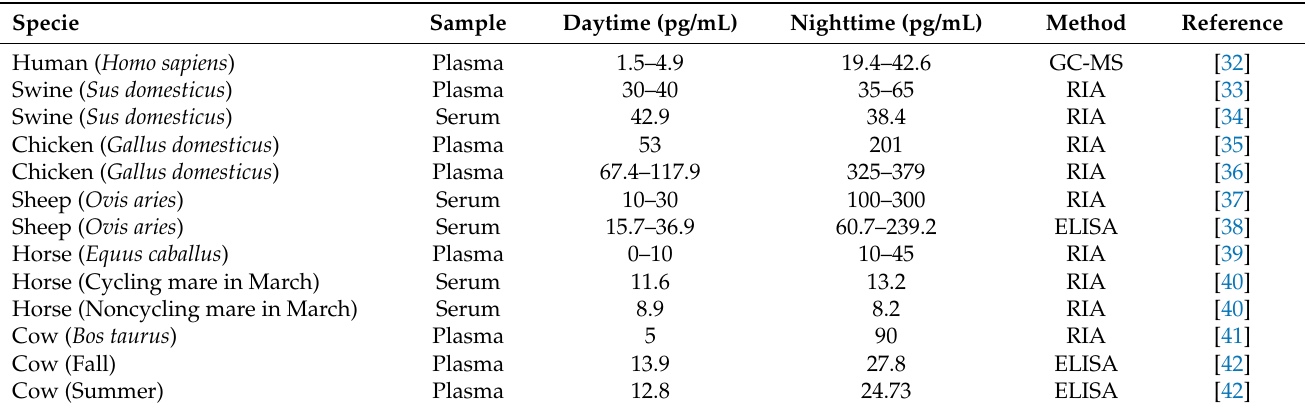
Table 1. Summary of melatonin concentrations across